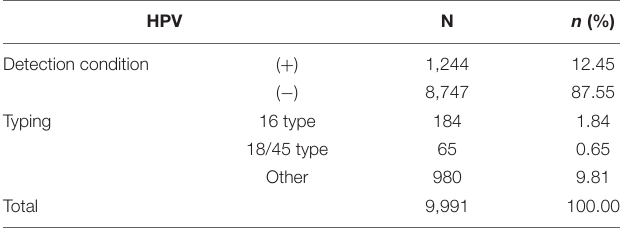
TABLE 7 | Human papillomavirus (HPV) screening results in cervical cancer.